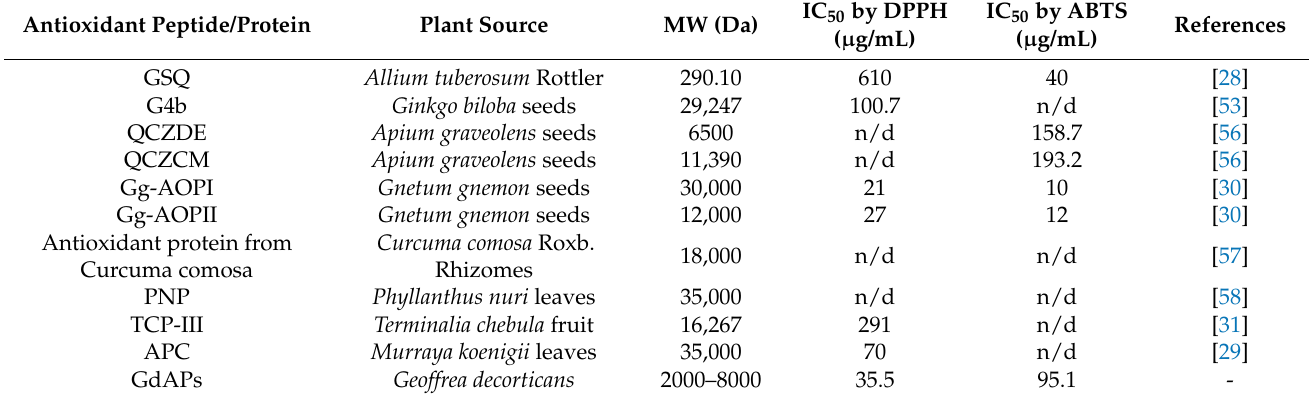
Table 2. Native antioxidant peptides/proteins isolated from plant sources in the last decade. Antioxidant Peptide/Protein Plant